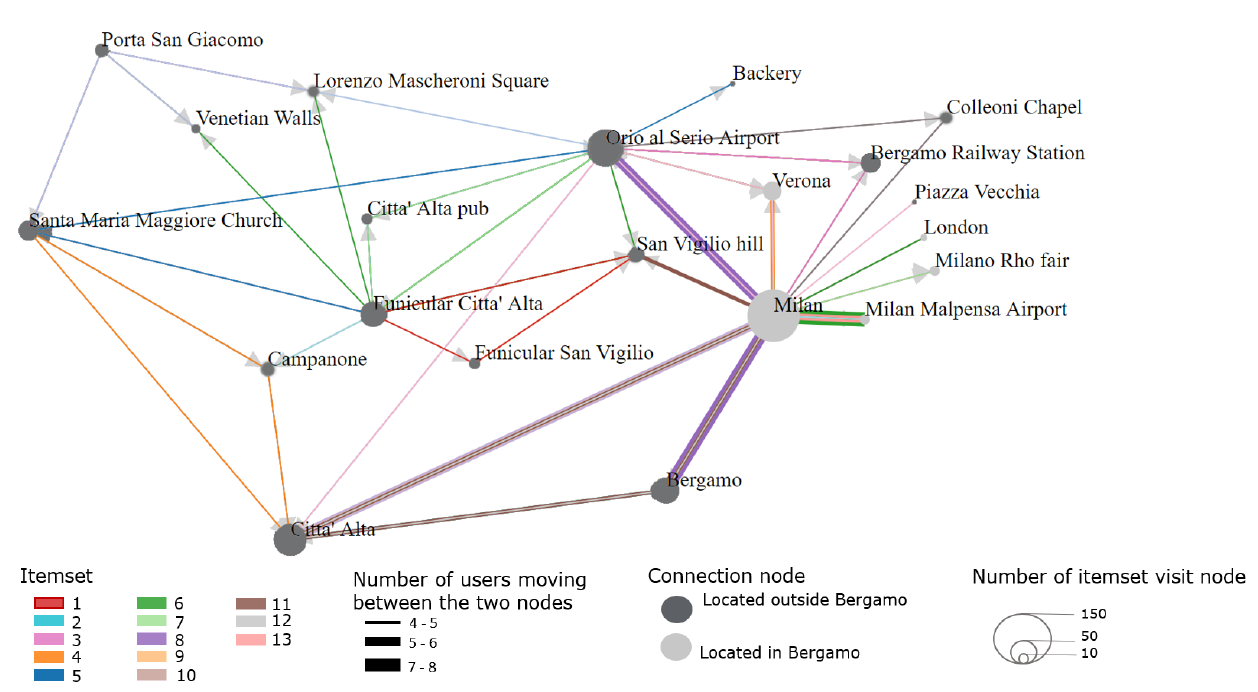
Figure 10. Topological representation for discovered itemsets associating indirect